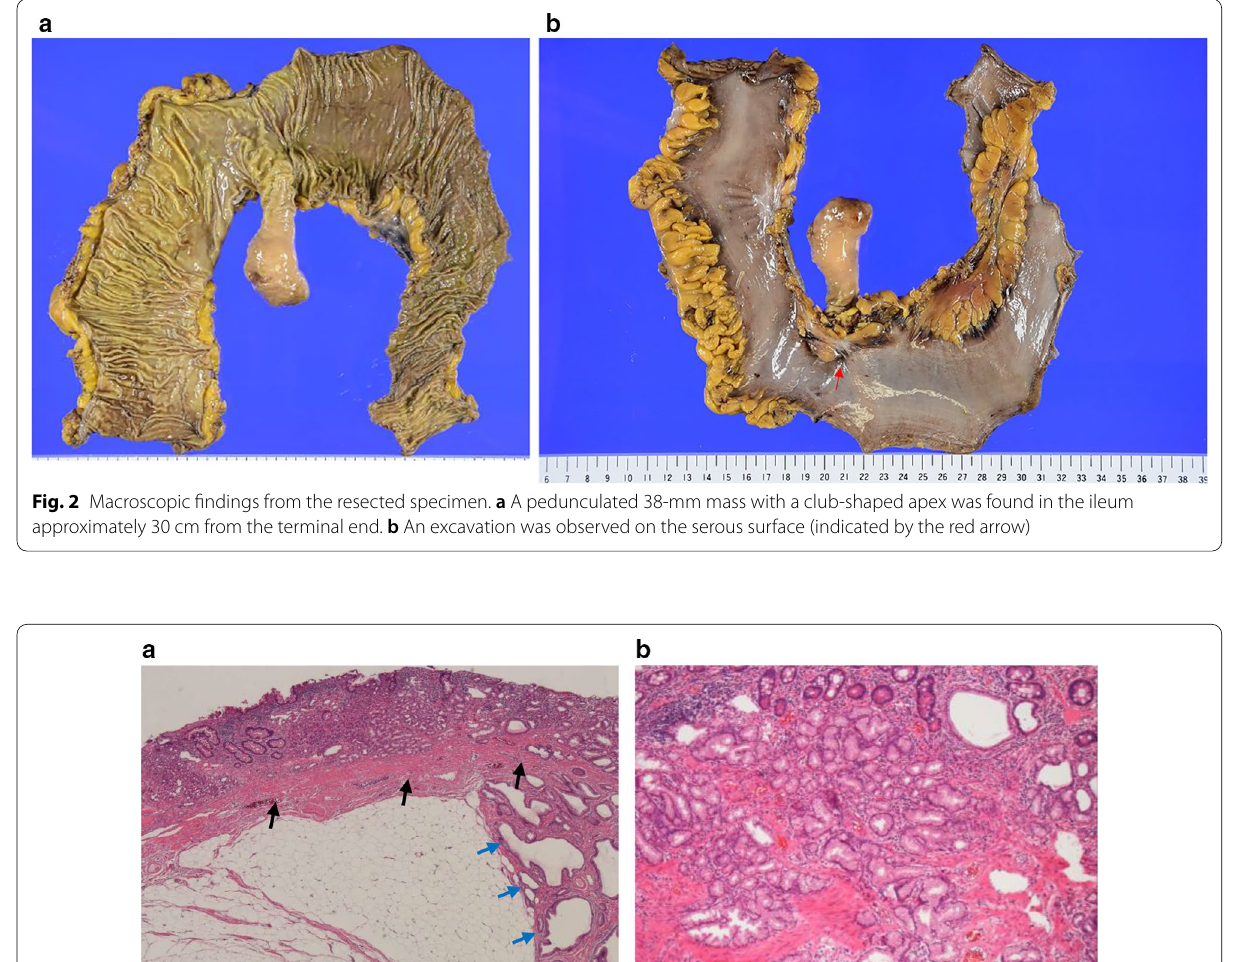
100). A mix of gastric ×